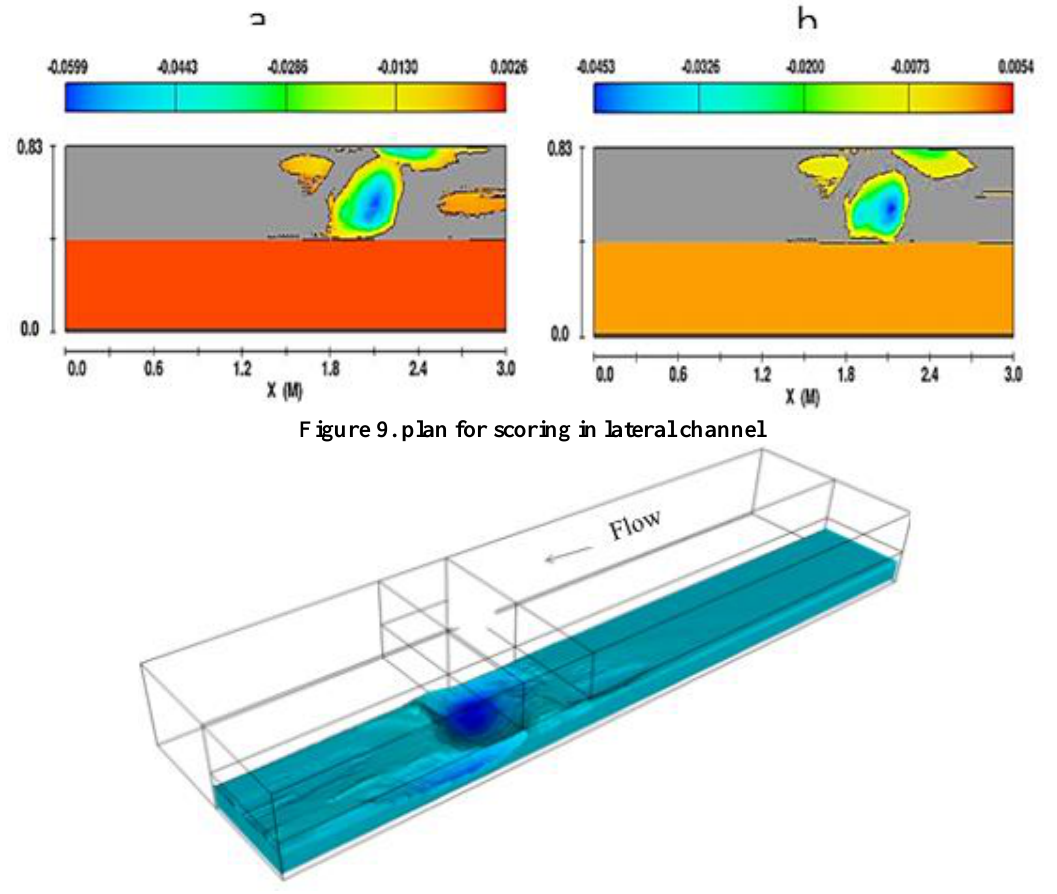
Figure 10. score hole in downstream of side